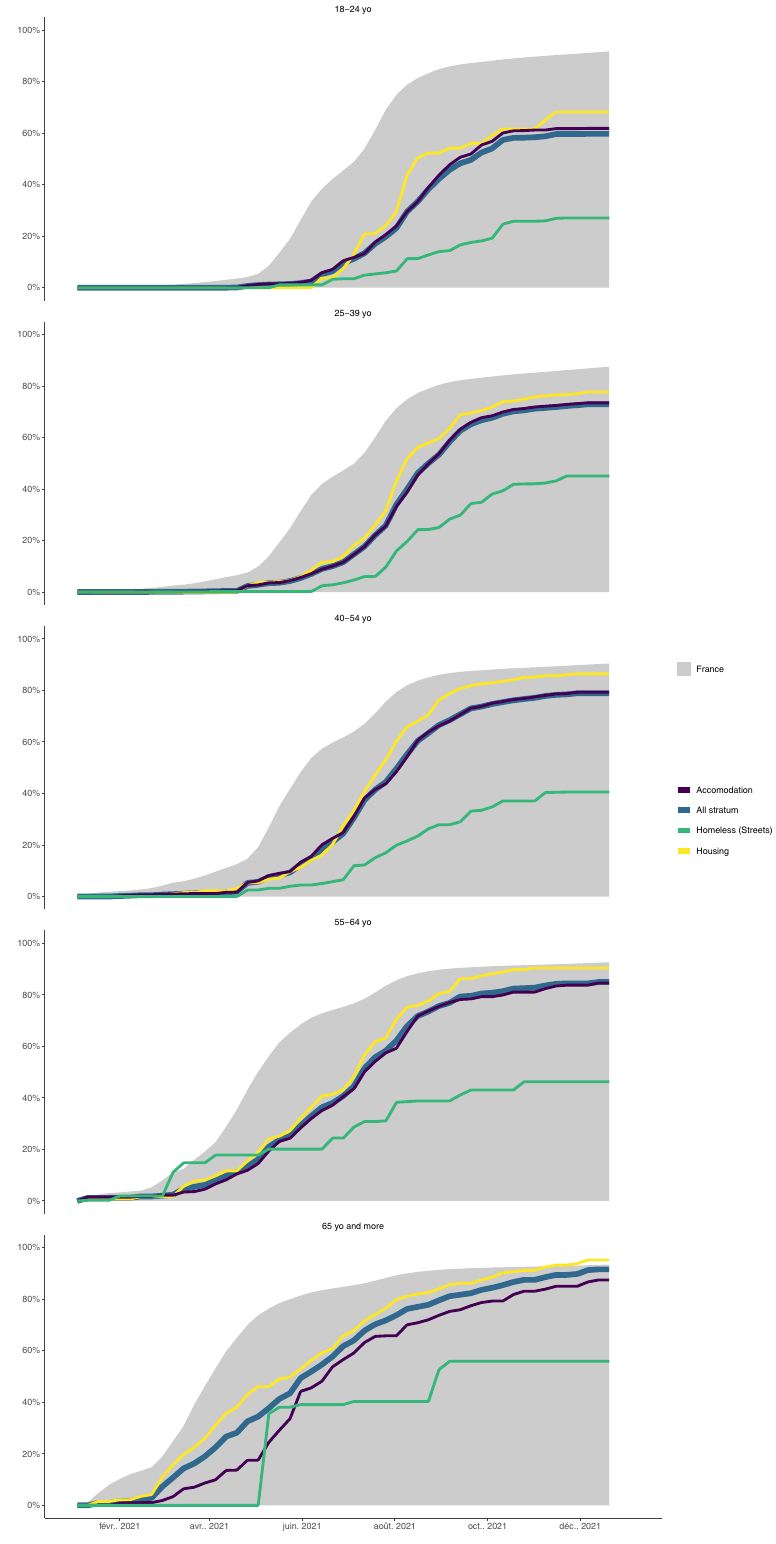
Fig. 3 Standardized vaccination rates by age categories: strata vs French general population. Yellow line is the standardized vaccine uptake for the Precariously Housed stratum (with corresponding 95% CIs yellow band), the purple line is standardized vaccine uptake for Accommodated stratum and the green line is the standardized vaccine uptake for the Streets stratum. Dark blue line is the standardized vaccine uptake for all strata combined and the grey area is the standardizedvaccineuptakefor all French adults above 18.Sample sizes areasfollows: n = 3690 fortheTotalsamplerepresentinga totalstandardizedpopulation of 100,567, n = 855 for Precariously Housed representing a standardized population of 22,788, n = 1321 for Accommodated representing a standardized population of 73,159 and n = 514 for Streets representing a standardized population of 4620. Population size for French adults above 18 was 52,751,109 as of December 28, 2021. Source data for this fi gure are available in Supplementary Data 11. A reproducibility guide for fi gures and tables is available in Supplementary Methods